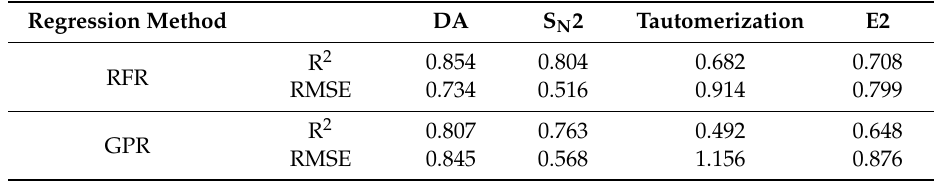
Table 2. Coe ffi cient of determination (R 2 ) and RMSE of predictions estimated using the nested 5-fold cross-validation (without considering the AD of